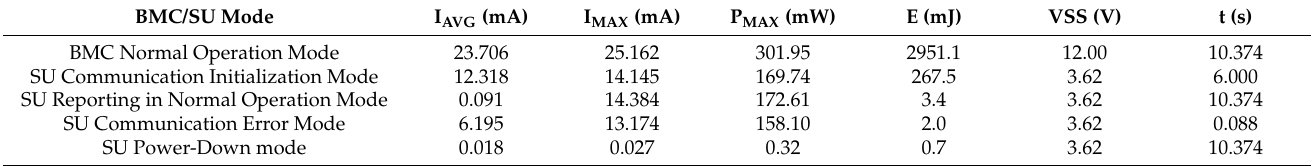
Figure 16. Energy consumption of the MBMS in all analyzed operating modes. Table 4. Power requirements comparison of the MBMS